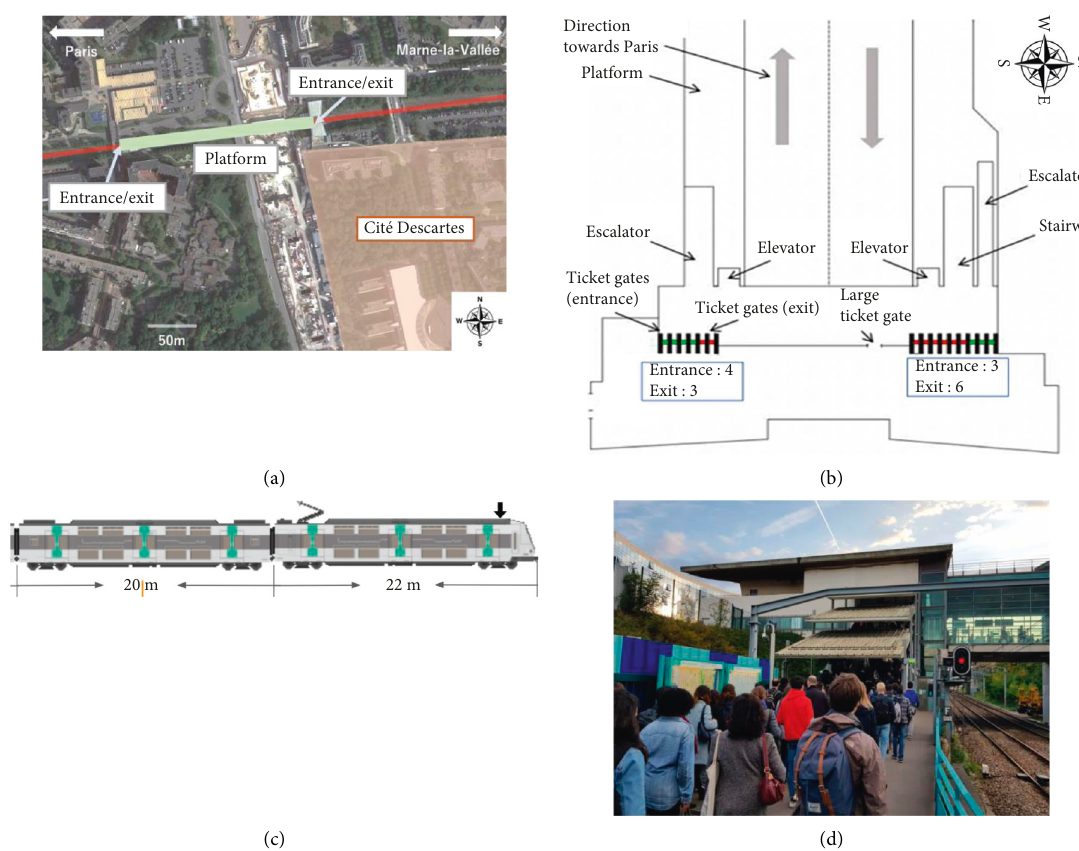
Figure 3: (a) Satellite photo of the site, (b) eastern side exit/entrance of the station, (c) train head, first two cars, and their doors (around green bands), and (d) eastern PEP of northern